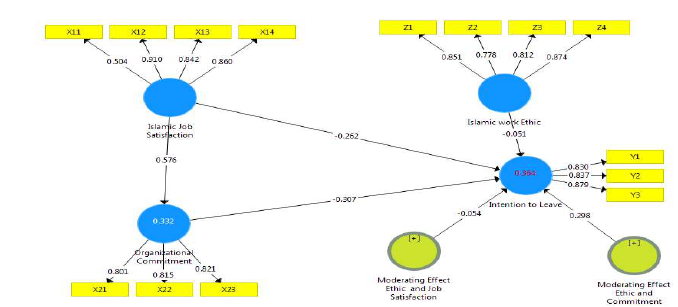
Fig. 1. Hypothesis Model, processed data (2018)